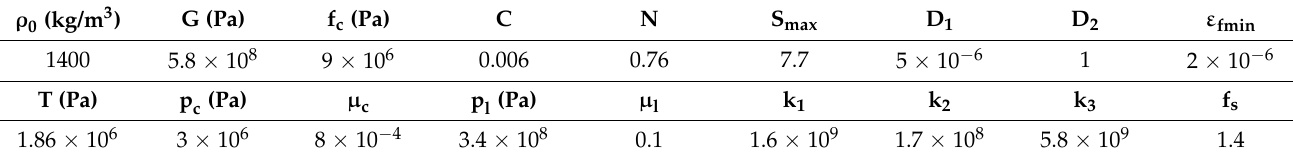
Table 1. Material model parameters of metal plate. Table 3. HJC material model parameters of